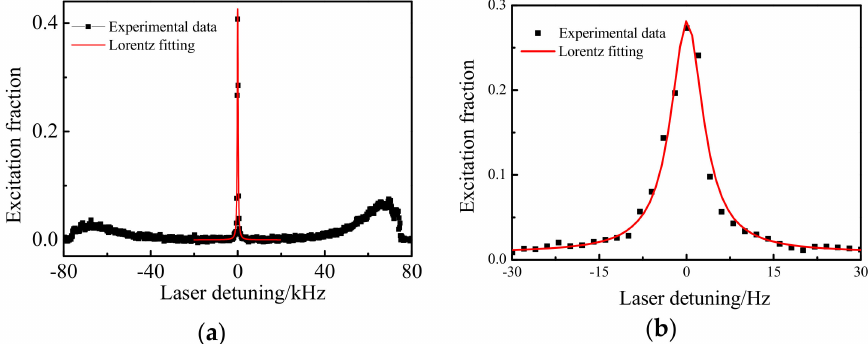
Figure 4. ( a ) Resolved sideband spectrum of the 87 Sr clock transition; ( b ) High resolution carrier spectrum of the clock